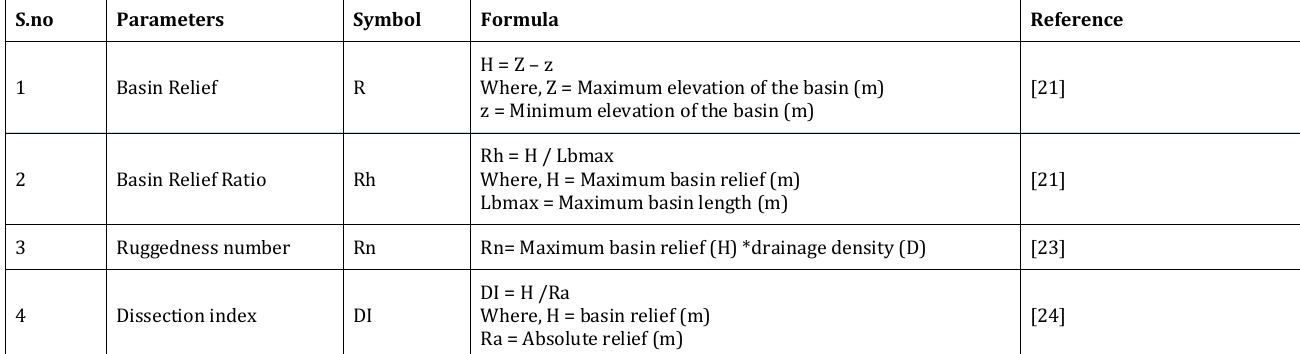
Table 2: Method of calculating relief aspects of drainage basin